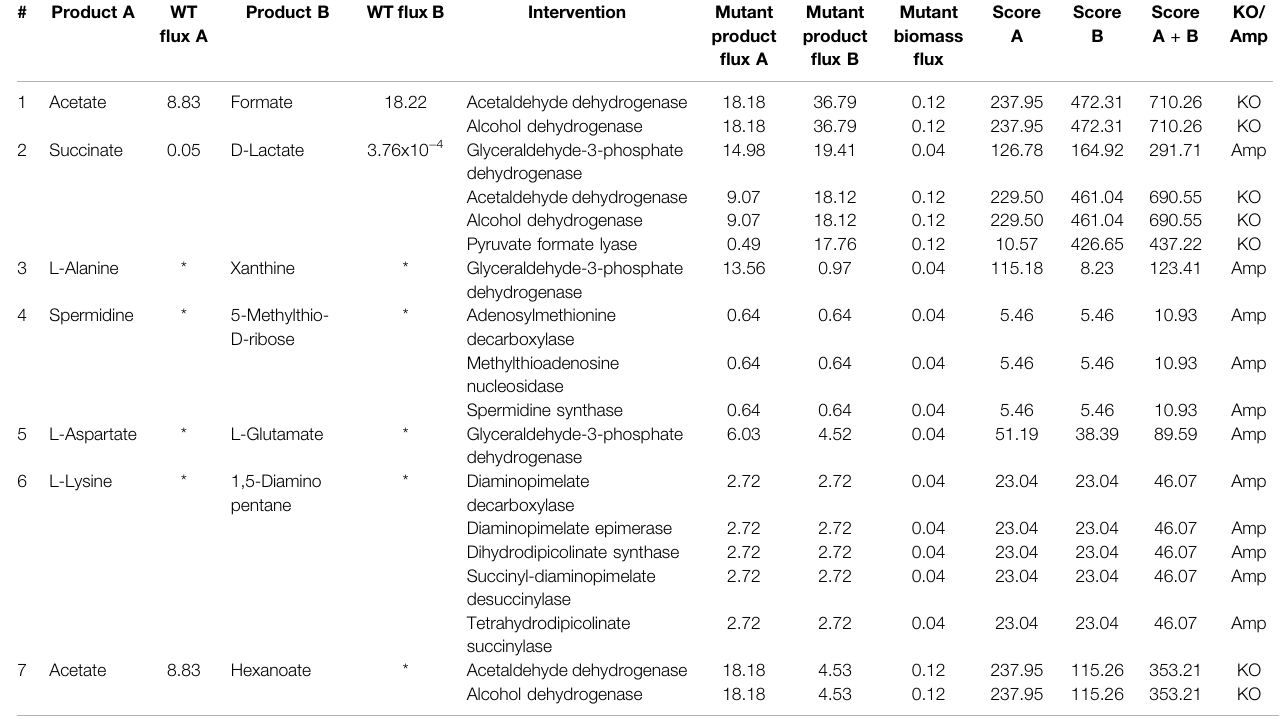
TABLE 2 | Intervention strategies for co-production of pairs of metabolites in E. coli under anaerobic conditions. # Product